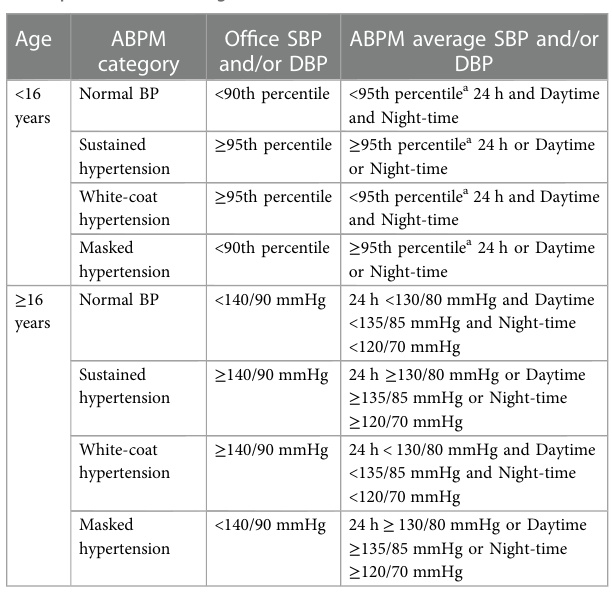
TABLE 8 Blood pressure phenotypes according to of fi ce and ambulatory blood pressure monitoring.